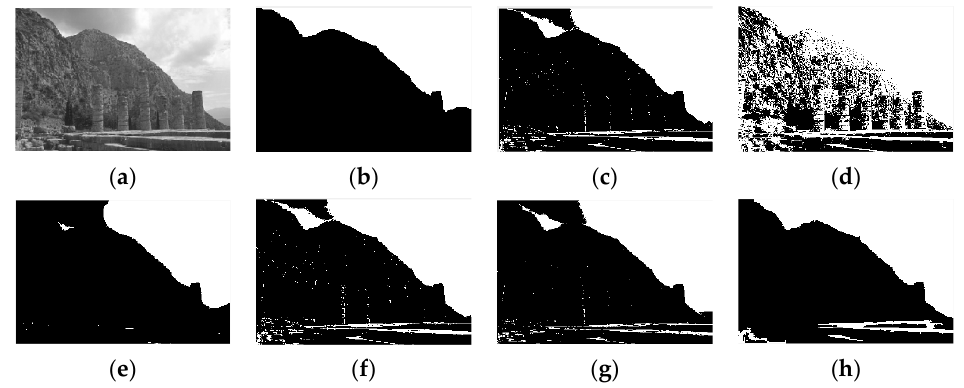
Figure 12. #198087 and its segmentations: ( a ) #198087, ( b ) ground-truth, ( c ) Otus, ( d ) MRCUT, ( e )